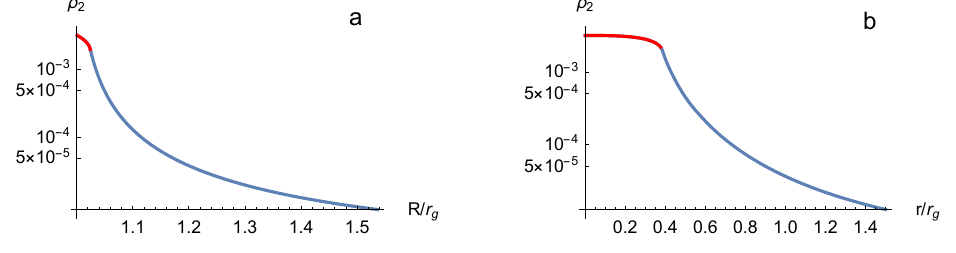
Figure 2. ( a ) ρ 2 –nergy density of the vacuum polarization in a form of “dark radiation” in the coordinates R > R i calculated for the eicheon parameters ρ 1 = 7 M 2 p r − 2 g , R i = 1.001 r g , R f = 1.024 r g , ρ 2 ( R f ) = 0.002 M 2 p r − 2 g . Red part of the curve corresponds to R i < R < R f , i.e., lies inside an eicheon. ( b ) ρ 2 calculated in the coordinates r of the metric (48). Red part of the curve corresponds to 0 < r < r f .